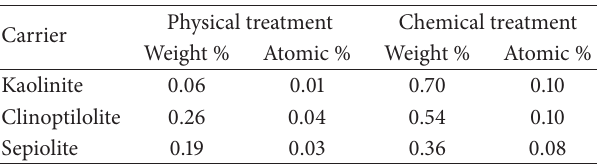
Table 4: Residual silver in physically and chemically treated clays after exposure to water